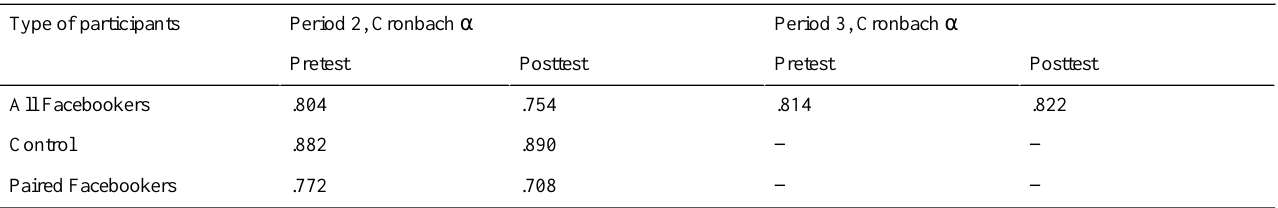
Table 2. Cronbach alphas for the 4 questions on alcohol and its association with festive moments for pre- and posttests and for participant group in the second and third periods.